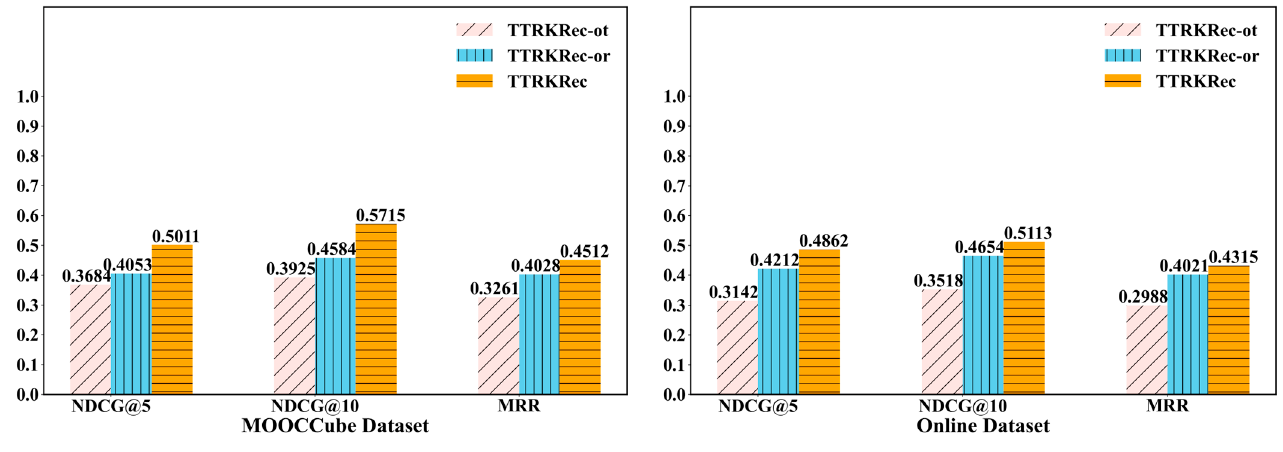
Figure 8. Recommended performance of different variants of TTRKRec on MOOCCube and Online datasets.